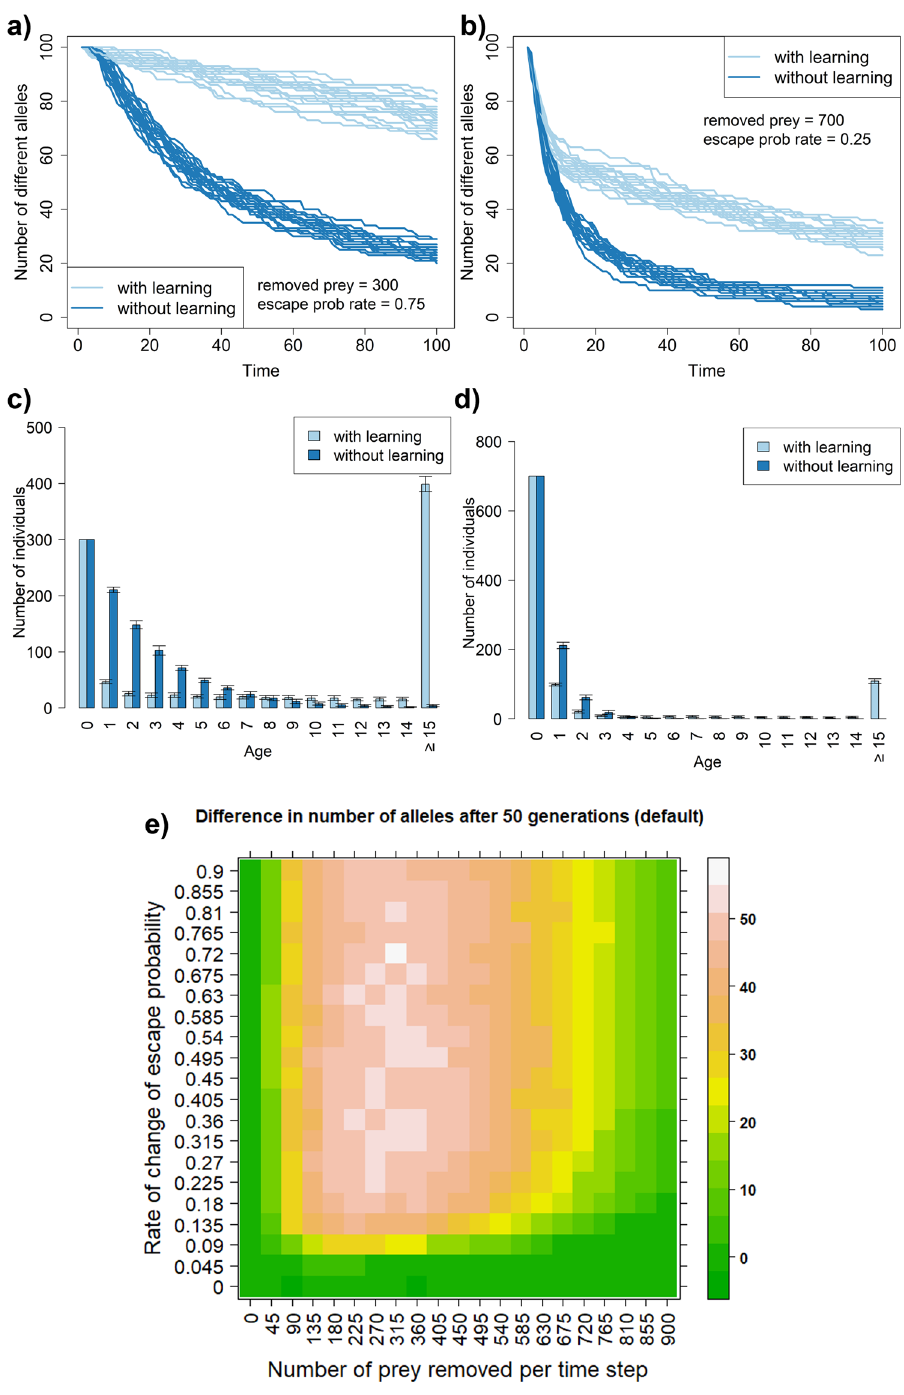
Figure 1. Intensity of predation modulates interaction of learning and genetic drift. Temporal dynamics of the number of alleles present in populations of prey subject to predation. Panels ( a ) and ( b ) show 20 simulation runs for both learning and non-learning scenarios. Panels ( c ) shows age distributions for panel ( a ) and panel ( d ) show age distribution for panels ( b ). The values in the heatmap are averages from 10 simulation runs. All prey populations consist of 1000 individuals at the beginning of each time step. Individuals killed by predators are replaced at the end of each step through reproduction of surviving individuals ("Methods"). Predators kill the same number of individuals in both learning and non-learning scenarios to allow for a fair comparison. The upper bound on the probability of avoiding or escaping a predator attack is set to 99%. The learning occurs in a default setting, i.e., at the end of every